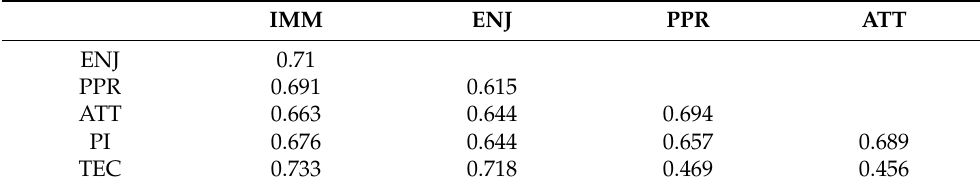
Table 2. Assessment of discriminant validity using the